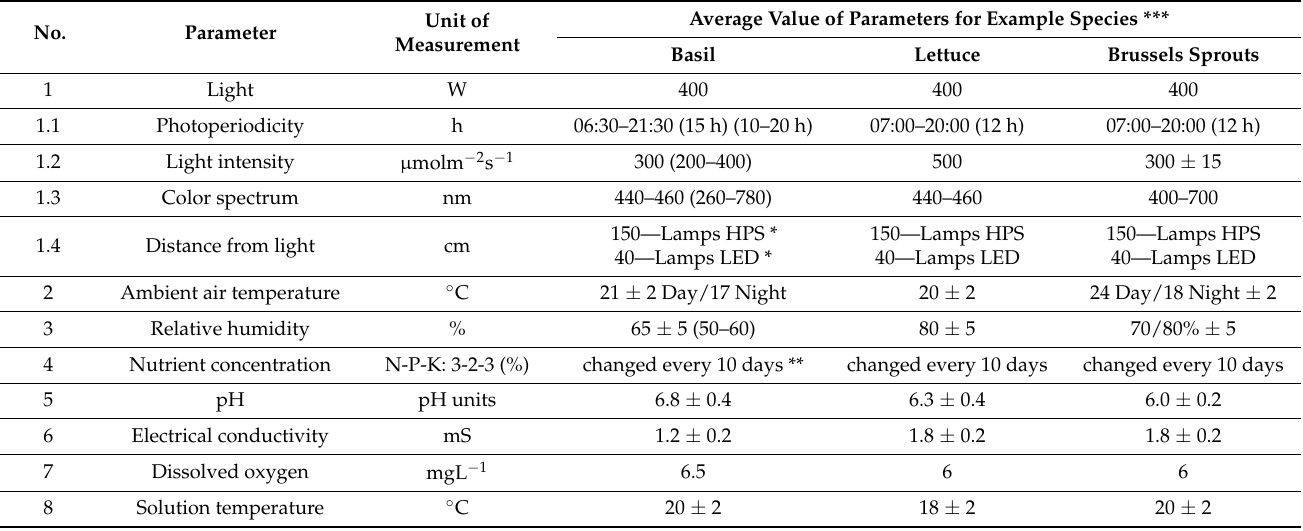
Table 1. Parameters defined for different species of microgreens continuously monitored and